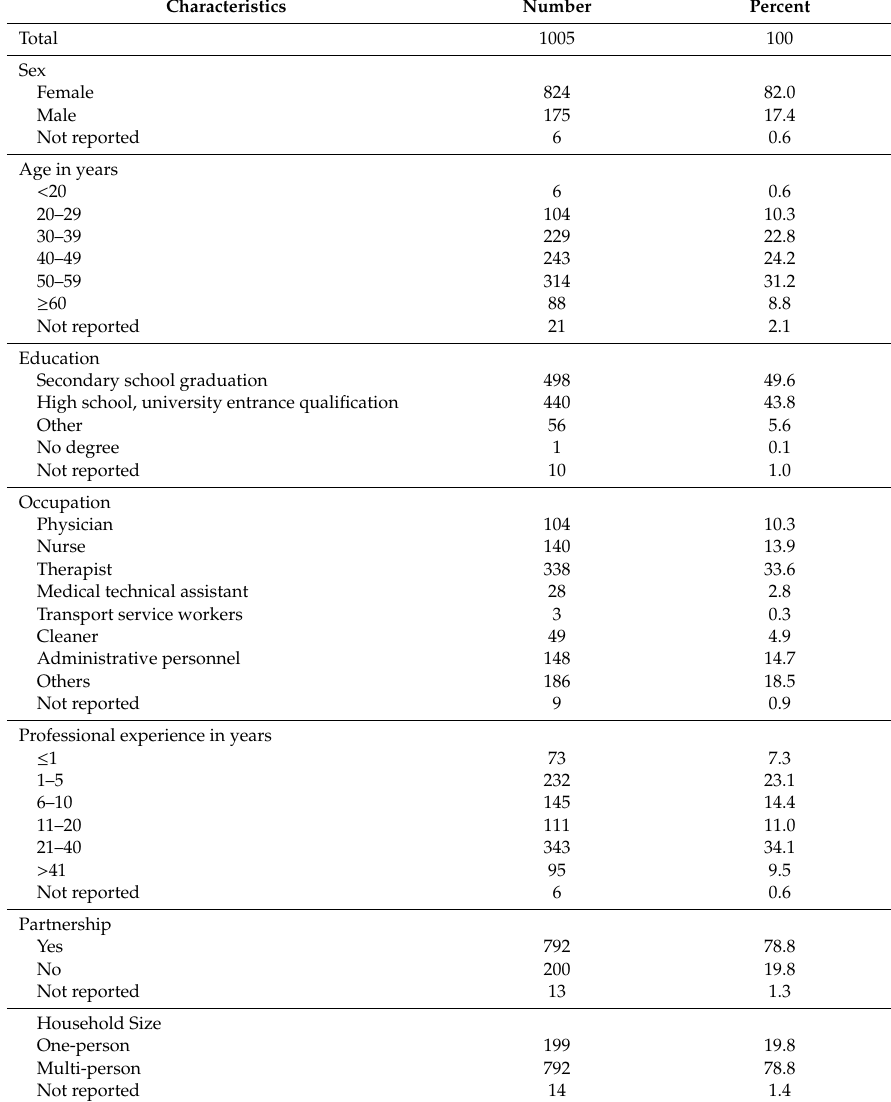
Table 1. Participant characteristics and methicillin-resistant Staphylococcus aureus (MRSA) risk factors.